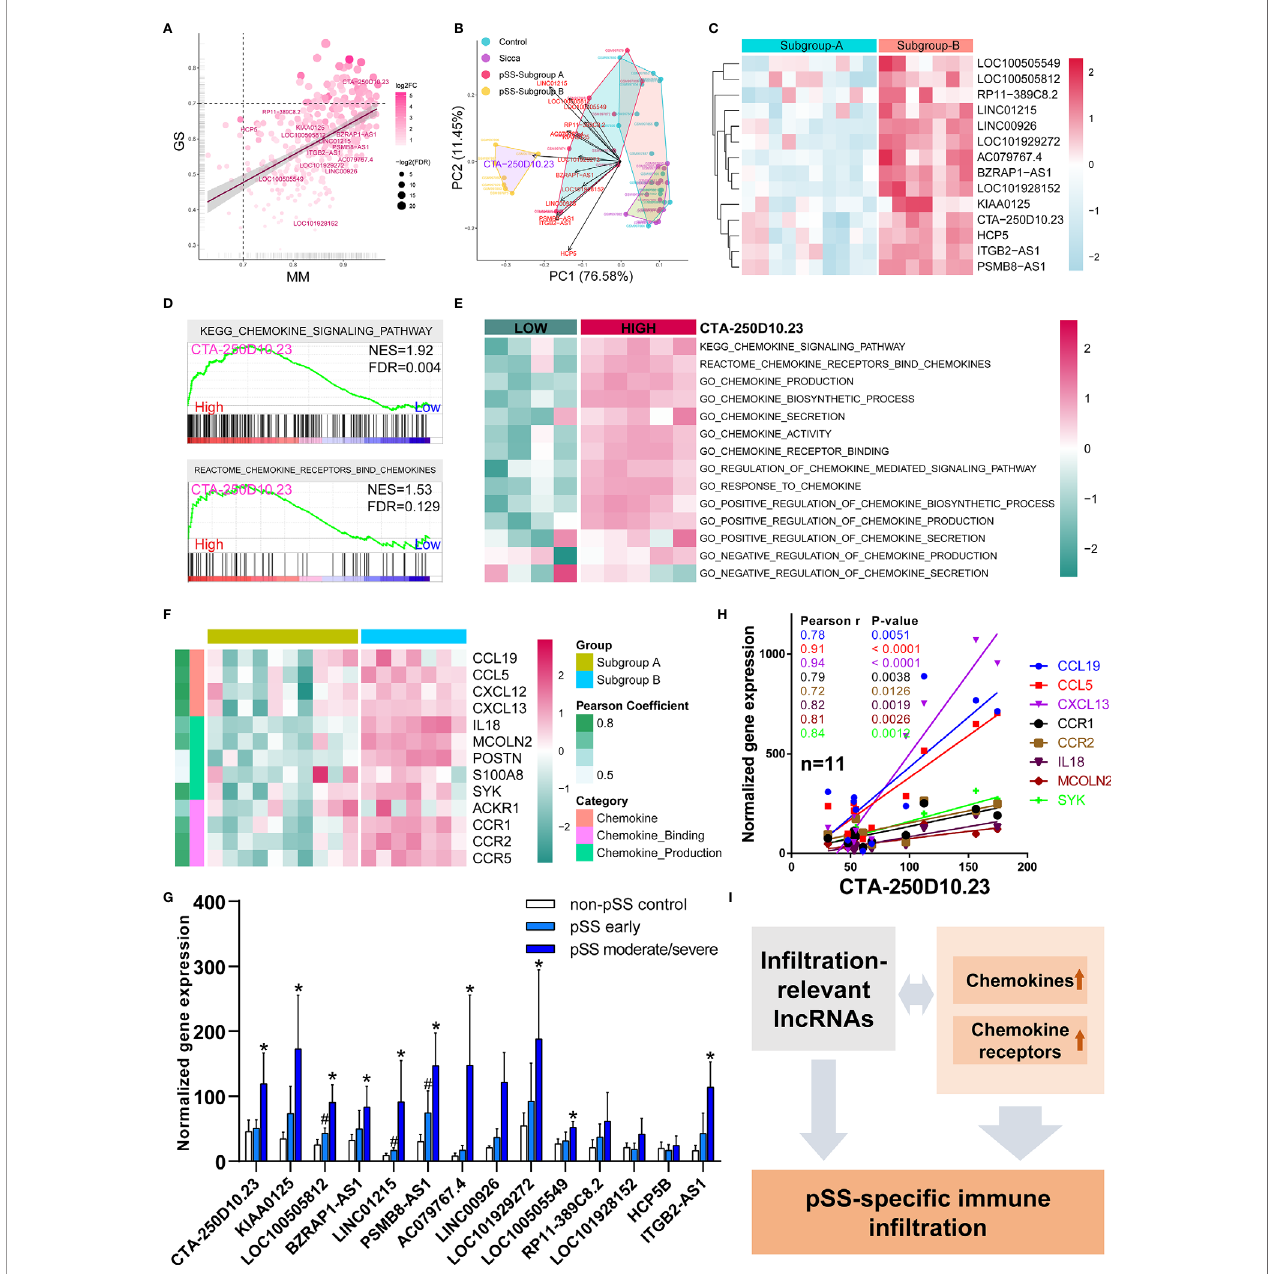
FIGURE 4 | CTA-250D10.23 lncRNA associated with the predicted pSS-speci fi c immune in fi ltration patterns and chemokine pathways. (A) Scatter plot of the gene signi fi cance (GS) for weight vs the module membership (MM) in the Blue module, estimated by WGNCA. Fourteen lncRNAs were identi fi ed in the Blue module, among which CTA-250D10.23 was the most signi fi cant one based GS and MM. (B) PCA of control, “ Sicca ” , pSS subgroup A and pSS subgroup B based on the 14-lncRNA signature in the Blue module. The CTA-250D10.23 lncRNA was the main contributor in the PCA plot in distinguishing between the pSS and non-pSS, and the subgroup A and subgroup B (C) Heatmap of the expression of 14 lncRNAs in the pSS subgroup A and B (D) GSEA of high- and low-expressing CTA- 250D10.23 pSS samples shows the relevance to chemokine pathways. (E) ssGSEA estimated scores of chemokine pathways in high- and low-expressing CTA- 250D10.23 pSS samples. The estimated scores of high-expressing group were higher than the low-expressing group. (F) Heatmap of the expression of chemokine- relevant genes coexpressed with CTA-250D10.23 lncRNA. (G) The expression of 14 lncRNAs in pSS patients in independent validation dataset GSE23117. 10 out of 14 lncRNAs were up-regulated in early or moderate/severe pSS or both. #P < 0.05, early pSS versus control; *P < 0.05, moderate/severe pSS versus control. (H) The correlation of the expression of CTA-250D10.23 lncRNA and the genes involved in chemokine pathways in the pSS patients (n = 11) of the independent validation dataset GSE23117. CTA-250D10.23 shows strong correlation with CXCL13 and CCL5 . (I) A model of potential mechanisms of the immune in fi ltration- relevant CTA-250D10.23 lncRNA and chemokine pathways linked to predicted pSS-speci fi c immune in fi ltration